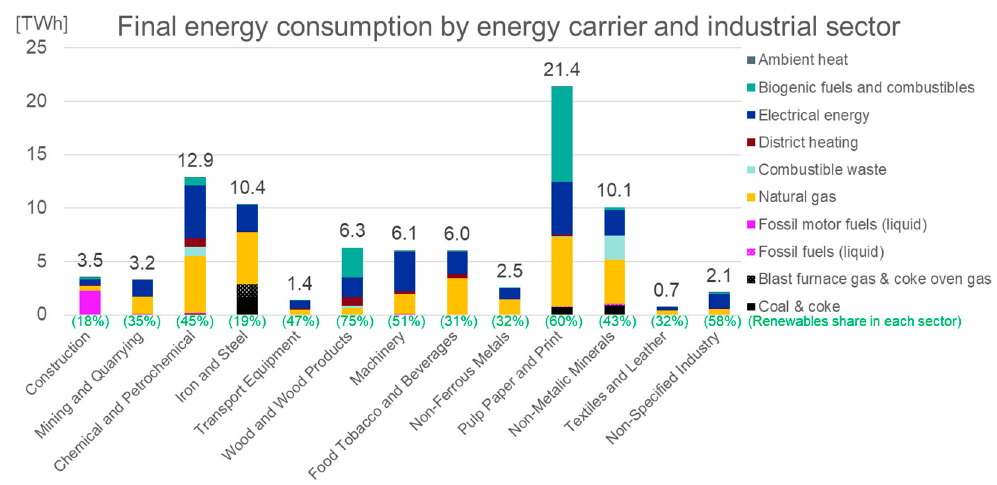
Figure 3. Final energy consumption [TWh] per energy carrier and industrial sector and their renewable shares [%] in Austria in 2019 [5].